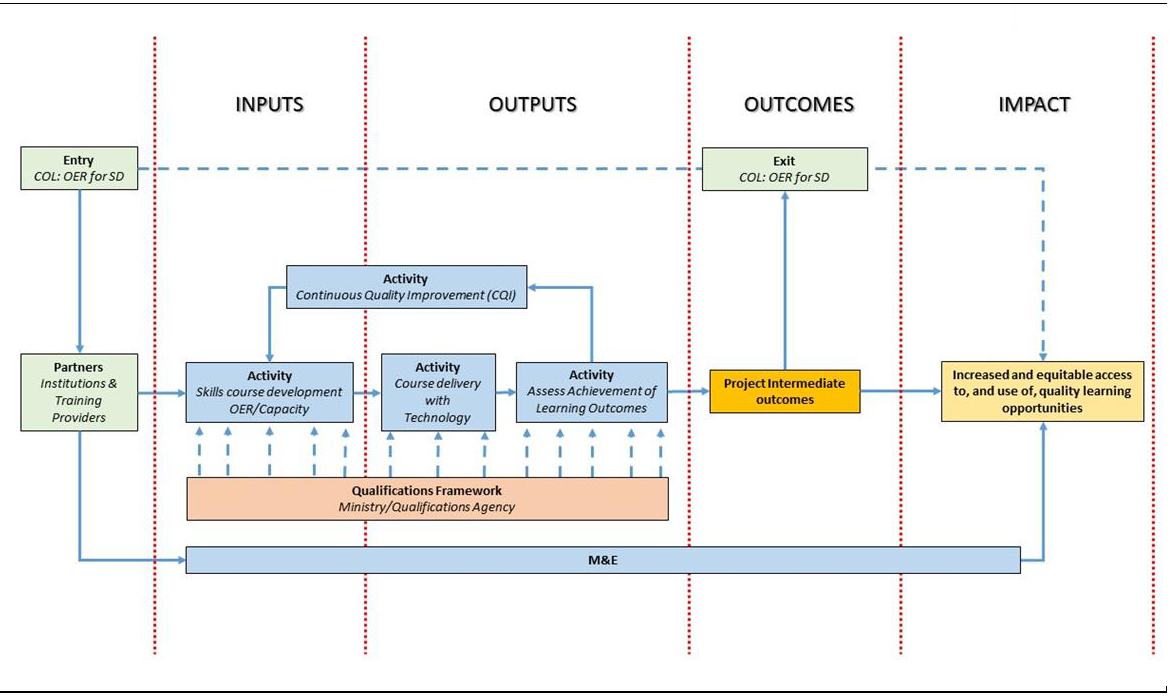
Figure 3 . OER for skills development project model.